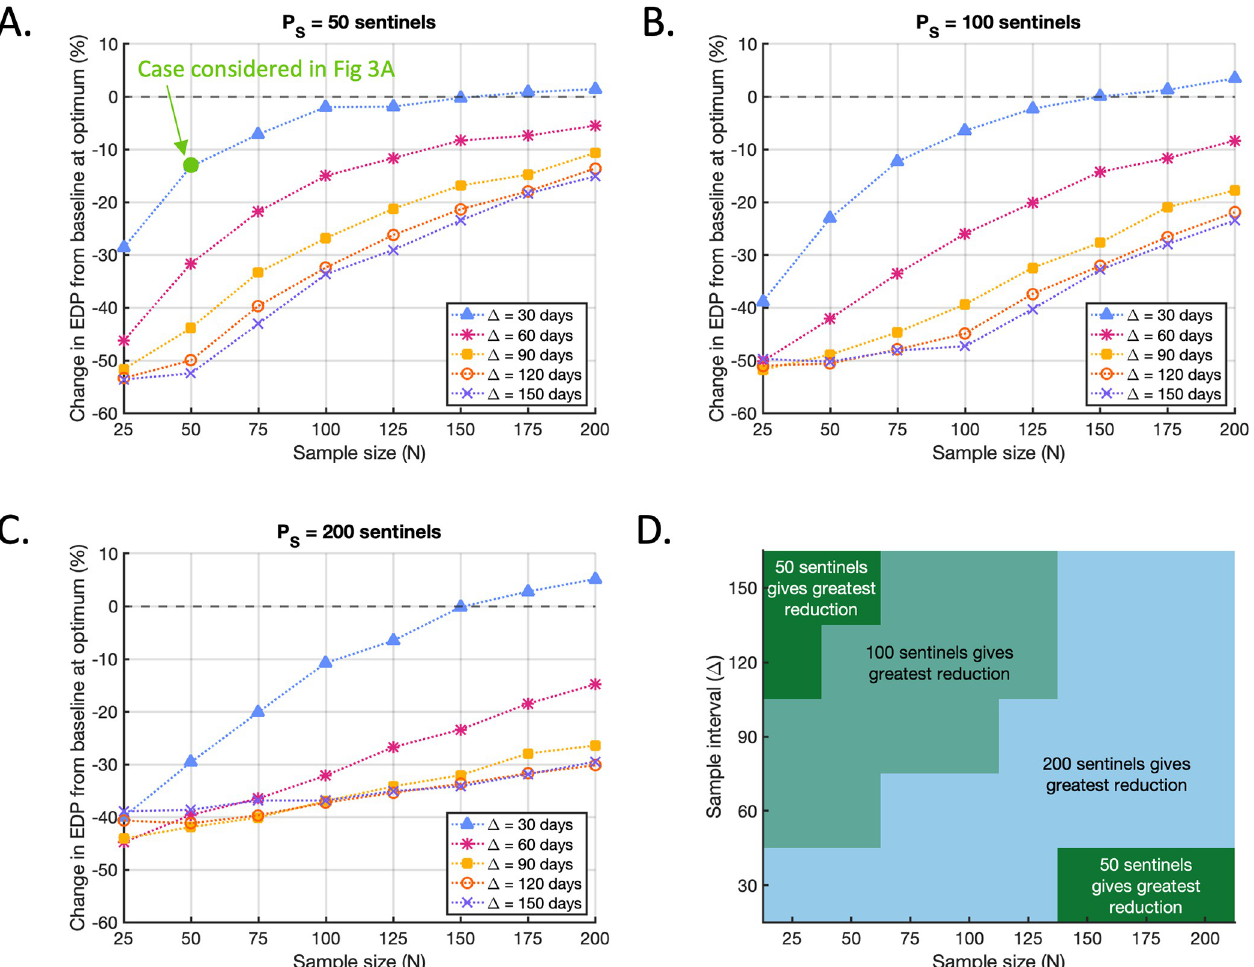
Fig 4. Optimal reductions in EDP compared to the baseline level. A. The best achievable percentage changes in the EDP compared to the baseline level for each ( N , Δ ) pair when P S = 50, corresponding to the optimal strategies identified in Fig 3B. Green circle marks the case considered in Fig 3A ( P S = 50, N = 50, Δ = 30 days). Note that the baseline level depends on N and Δ (Fig 2C, S12A Fig), so the relative changes in EDP shown here are not a measure of the resultant EDP. The resultant EDP decreases with sampling effort (S12B, S12C and S12D Fig). B. The analogous figure to A, but with P population and results corresponding to the strategies identified in Fig 3C. C. The analogous figure to A, but with P S = 200 sentinels added to the population and results corresponding to the strategies identified in Fig 3D. D. Combinations of the sample size N and sample interval Δ for which adding P green), P S = 100 (light green) or P S = 200 (blue) sentinels to the population led to the greatest reduction in the EDP compared to the baseline level (of the three values of P S